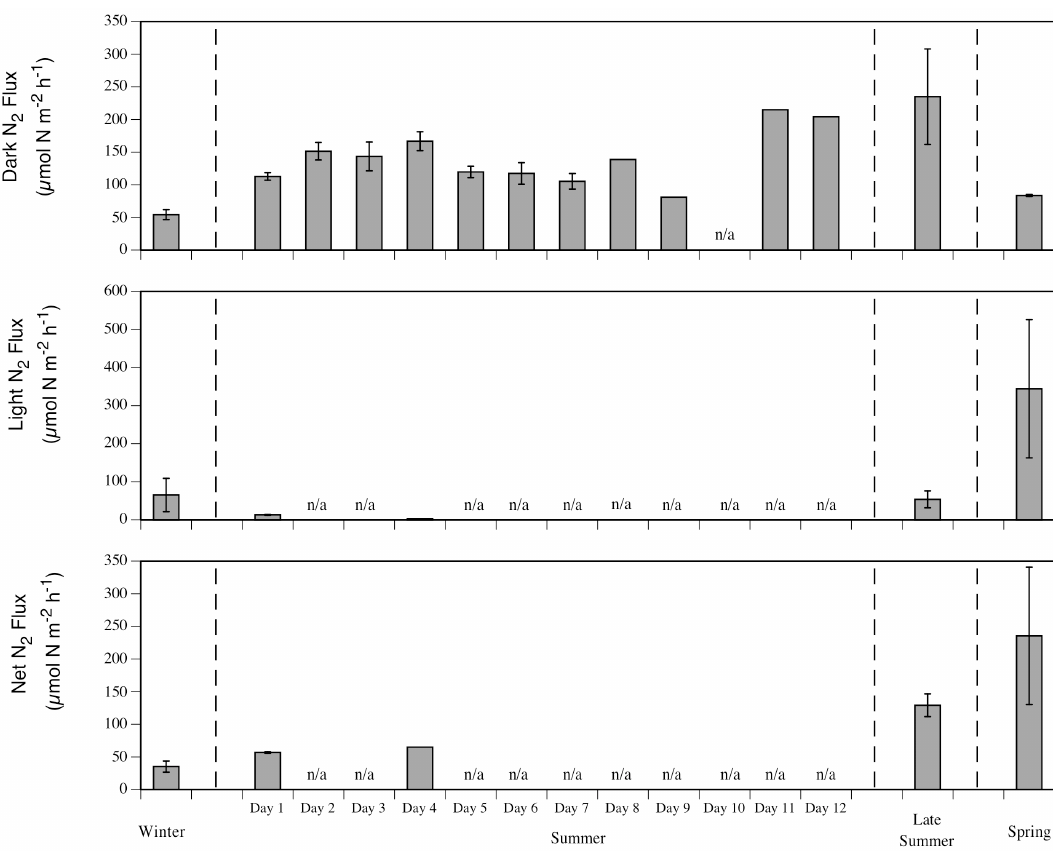
Fig. 4. Benthic dark, light, and net dinitrogen gas (N 2 ) fluxes (mean ± SE where replicated; see Table 1). n/a = no data available due to O 2 saturation of the chamber water (see